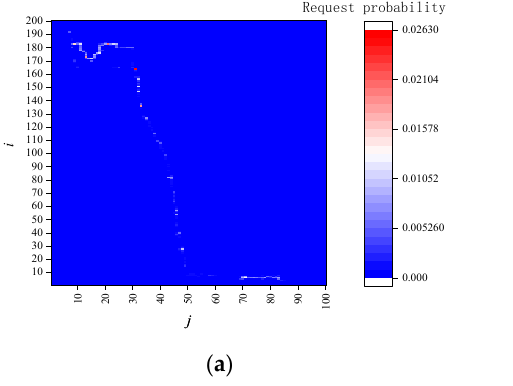
Figure 4. The schematic diagram of vehicle user trajectory.